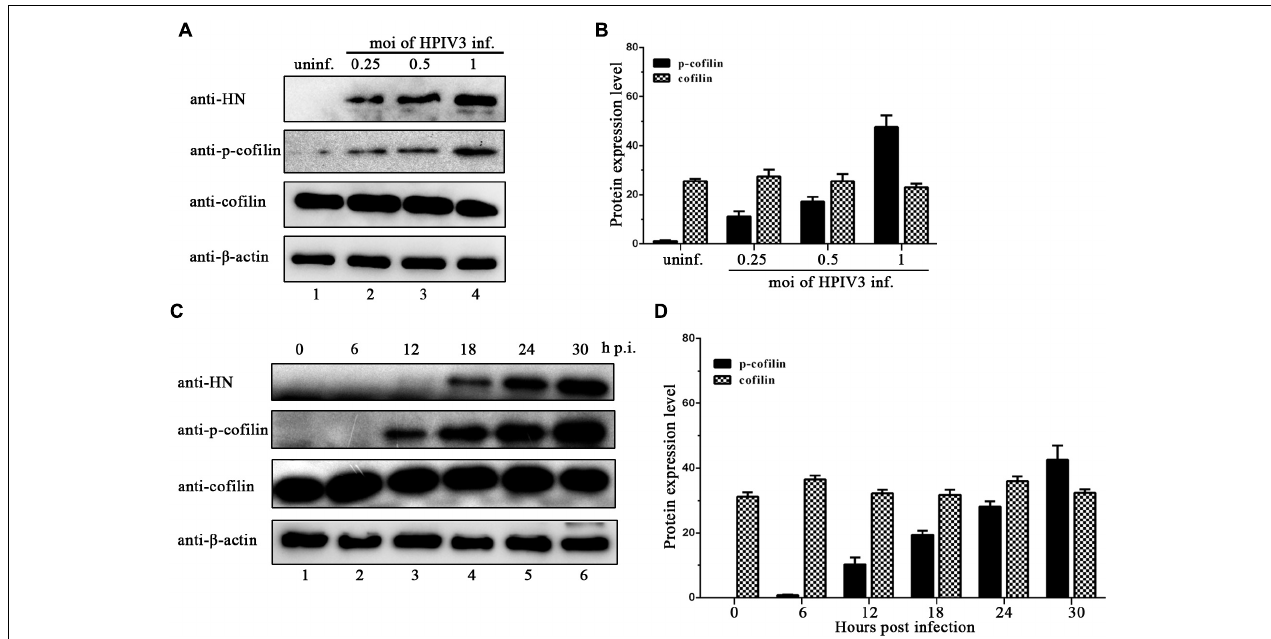
FIGURE 5 | HPIV3 infection induces cofilin phosphorylation. (A,B) Hela cells were mock infected or infected with HPIV3 at MOI of 0.25, 0.5, and 1, respectively. At 24 h after infection, the cells were collected and subjected to WB to determine the protein expression level of viral HN, cellular cofilin, p-cofilin and β -actin. Relative expression level of cofilin and p-cofilin were calculated by normalized to that of β -actin. (C,D) Hela cells were infected with HPIV3 at MOI of 1 and cultured for 0, 6, 12, 18, 24, 30 h. At different time points, cells were collected and subjected to WB as described in the legend of (A,B) .